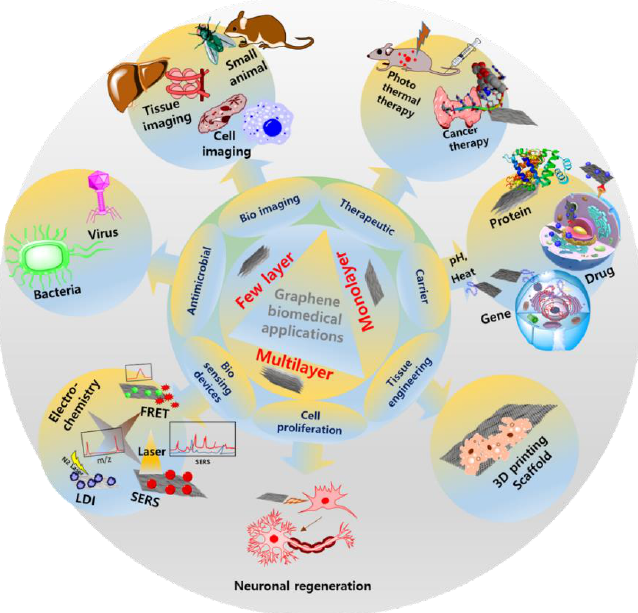
Figure 11. Cartoon illustrating the applications of monolayer, few-layer, and multi-layer graphene. Stimuli Response